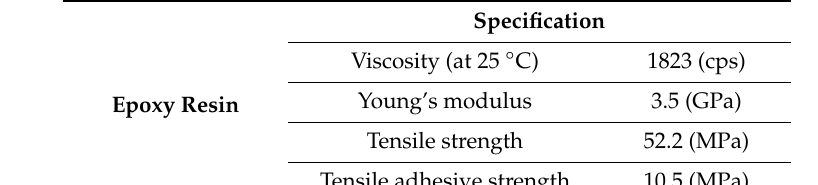
Table 4. Material properties of the epoxy resin.